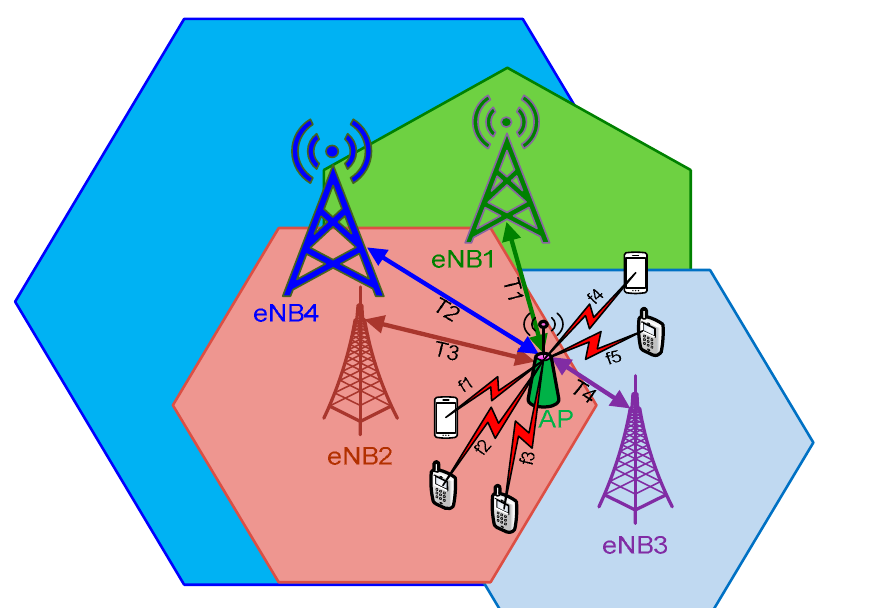
Figure 1. The considered networking scenario.